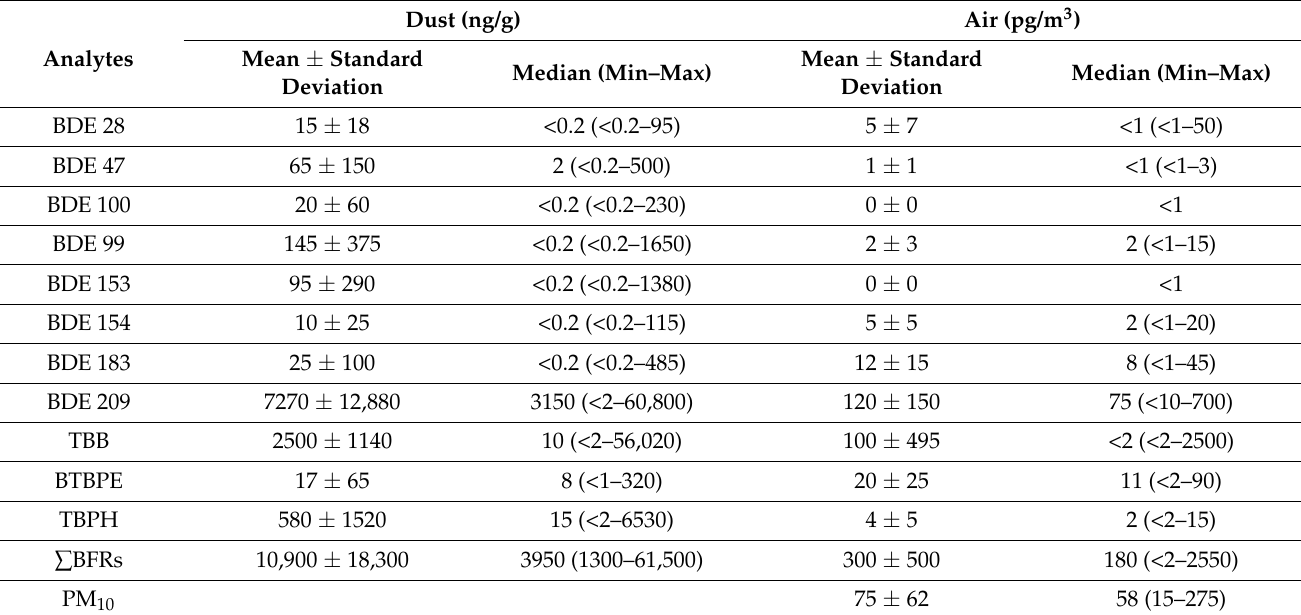
Table 1. Concentrations (ng/g) of analyzed BFRs in indoor dust (ng/g) and PM 10 (pg/m 3 ) collected from Saudi children room in Jeddah, Saudi